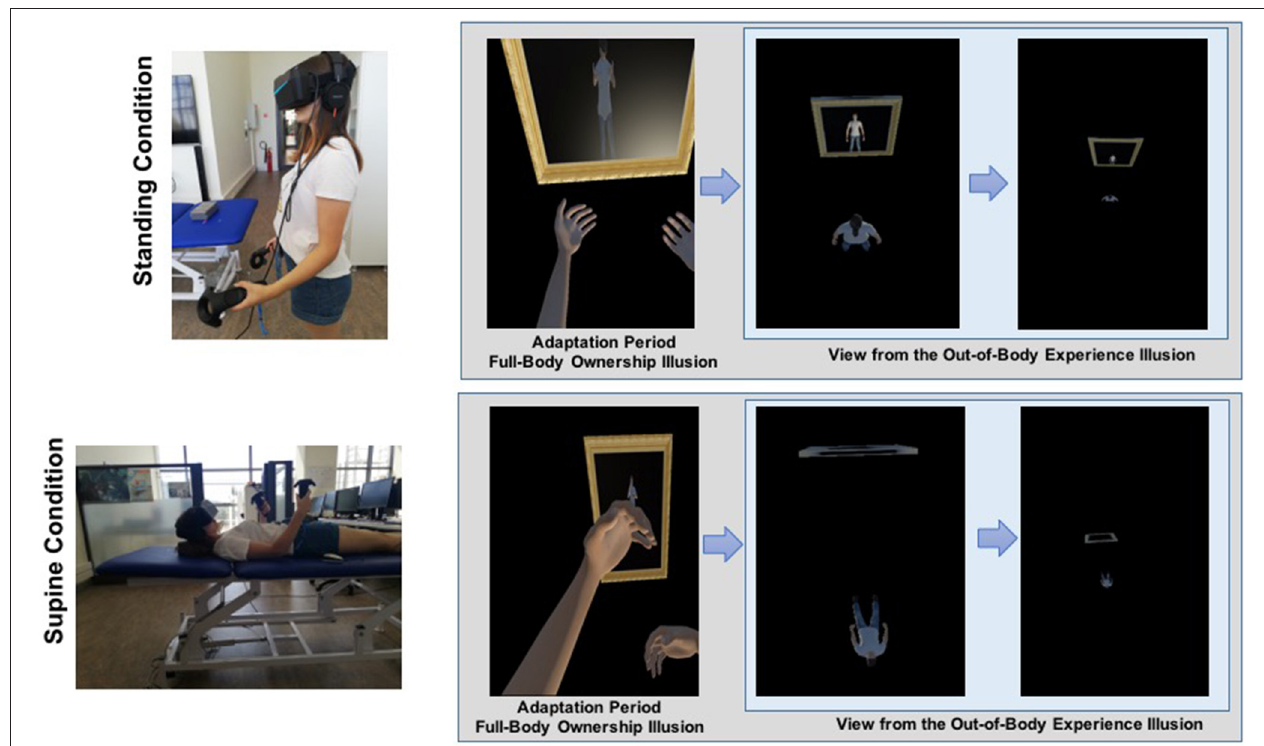
FIGURE 1 | Illustration of the experimental design. (A) Standing condition and (B) supine condition. During the full-body ownership illusion, participants experience the virtual body from the first-person perspective (1PP) while being subjected to synchronous visuo-tactile stimulation. In the virtual out-of-body experiences, 1PP of participants is shifted toward up, 14m above the virtual body.